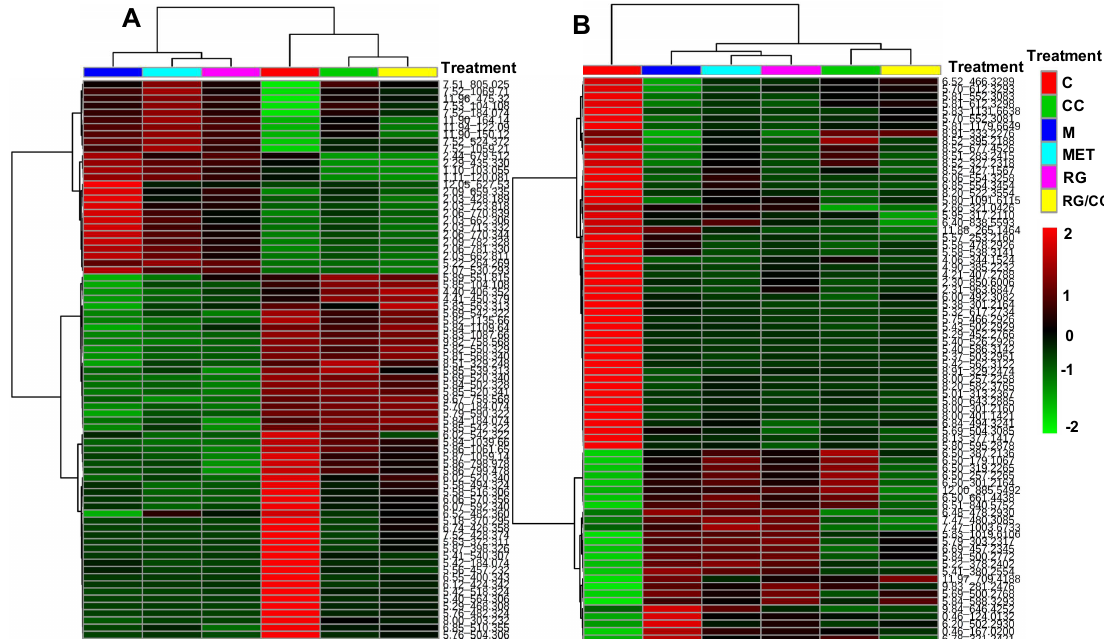
Figure 6. Hierarchical clustering analysis of HFD-induced differential metabolites among different treatments. The heatmaps were generated in MetaboAnalyst 4.0 (http://www.metaboanalyst.ca/) using the differential biomarkers of importance identified between the normal control group (C) and diabetic model control group (M). ( A ) ESI + mode; ( B ) ESI − mode. The results showed that CC and its combination with RG were clustered closer to the undiabetic control group, indicating that CC served as a sovereign drug and had a better modulation on diabetes-related metabolites in serum than RG alone and the positive drug metformin.